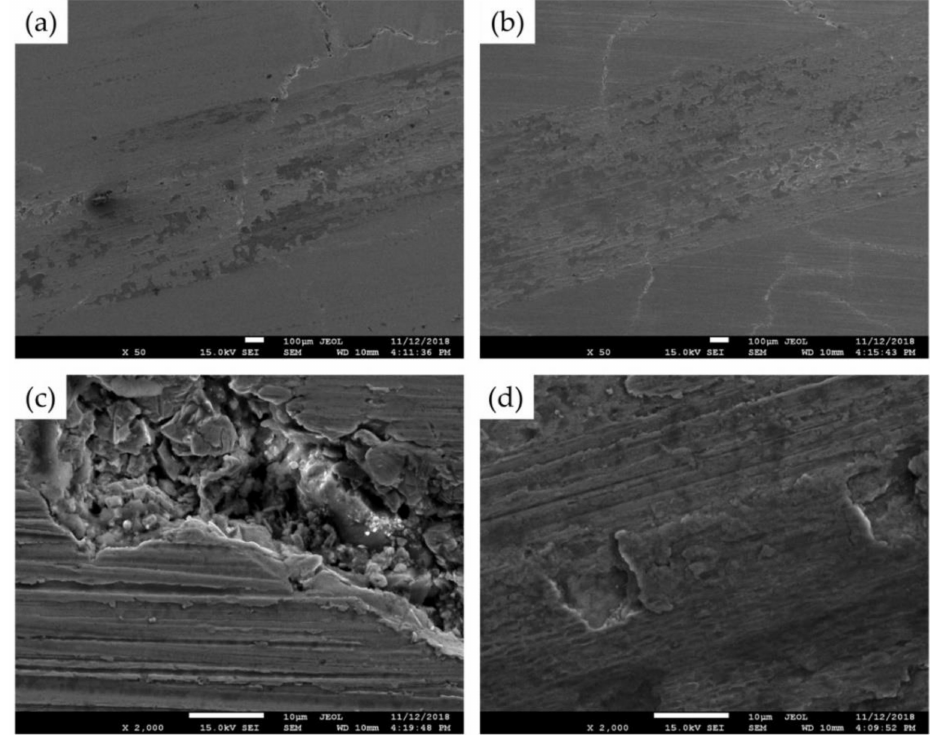
Figure 20. Wear surfaces of ( a , c ) the as-deposited K417G and ( b , d ) the as-remelted